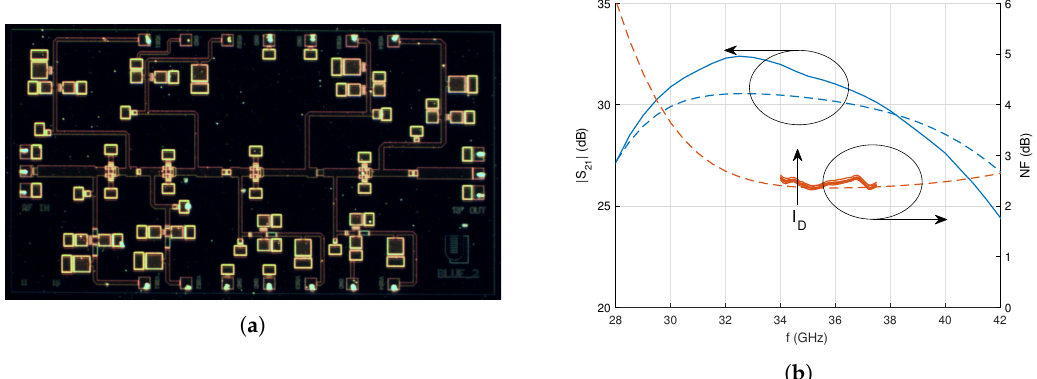
Figure 11. 4-stage LNA in the D01GH process: ( a ) Picture. ( b ) Performance. Continuous traces: measurements. Dashed traces: simulations. The nominal operating point is V DD = 5 V, I D = 150 mA. The variation of NF for drain currents from 109 mA to 182 mA is also shown.